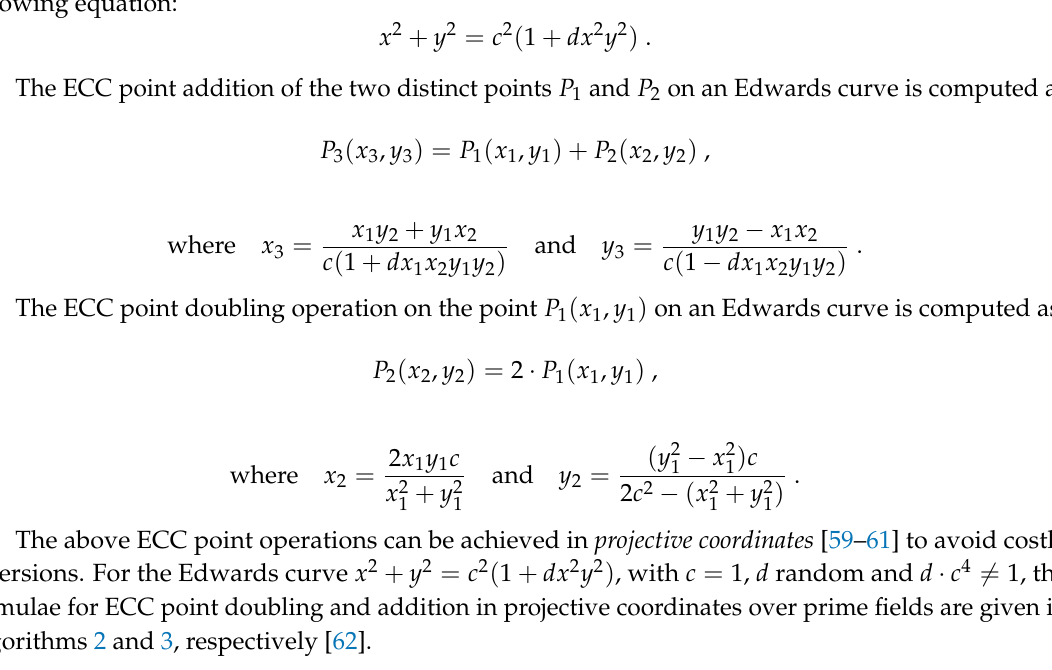
Algorithm 2: Elliptic curve point doubling in projective coordinates over prime fields using Edwards curves